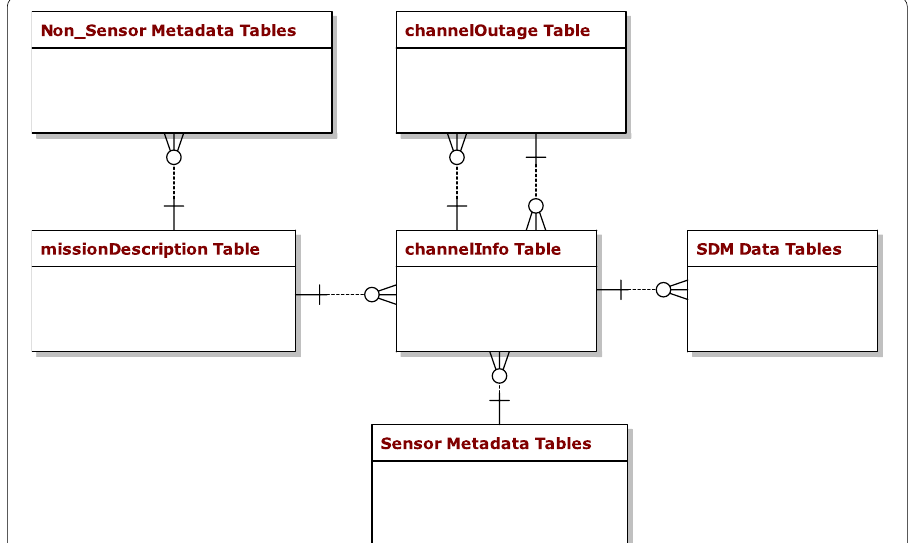
associated with the data